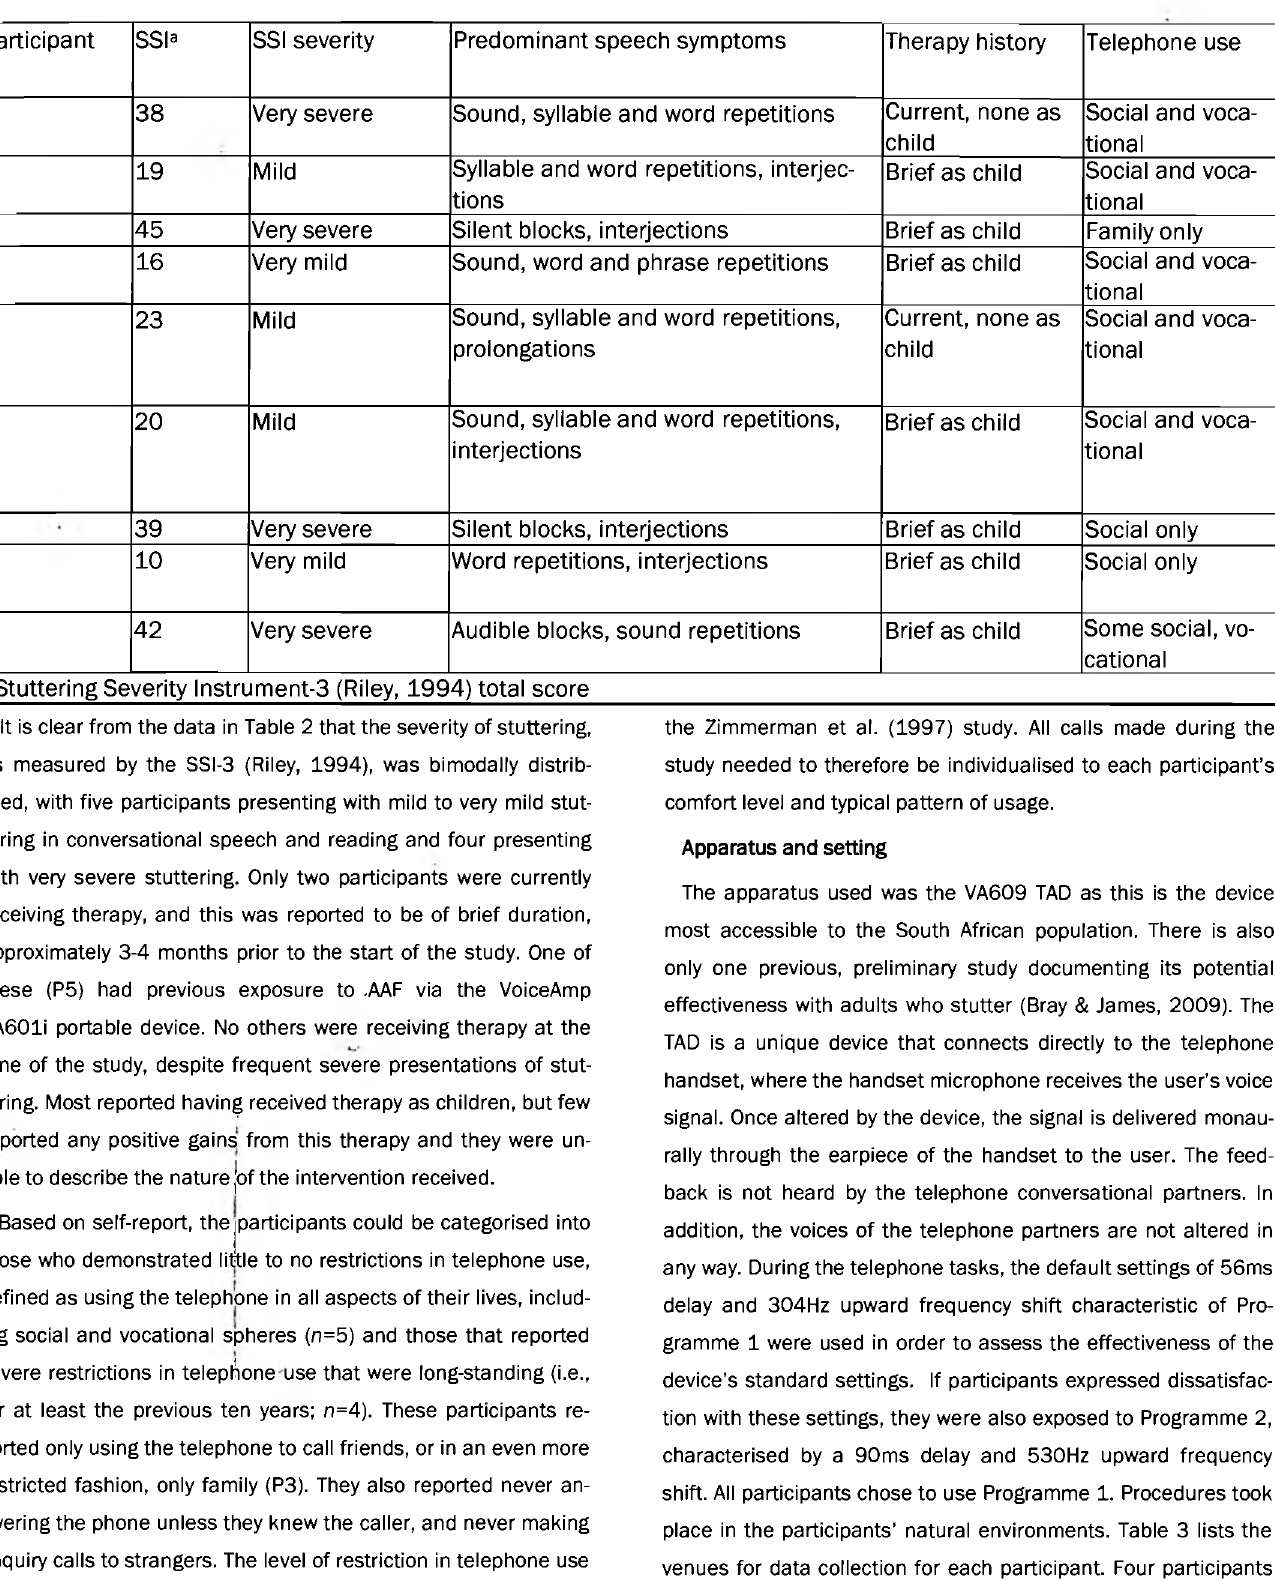
Table 2. Stuttering characteristics of